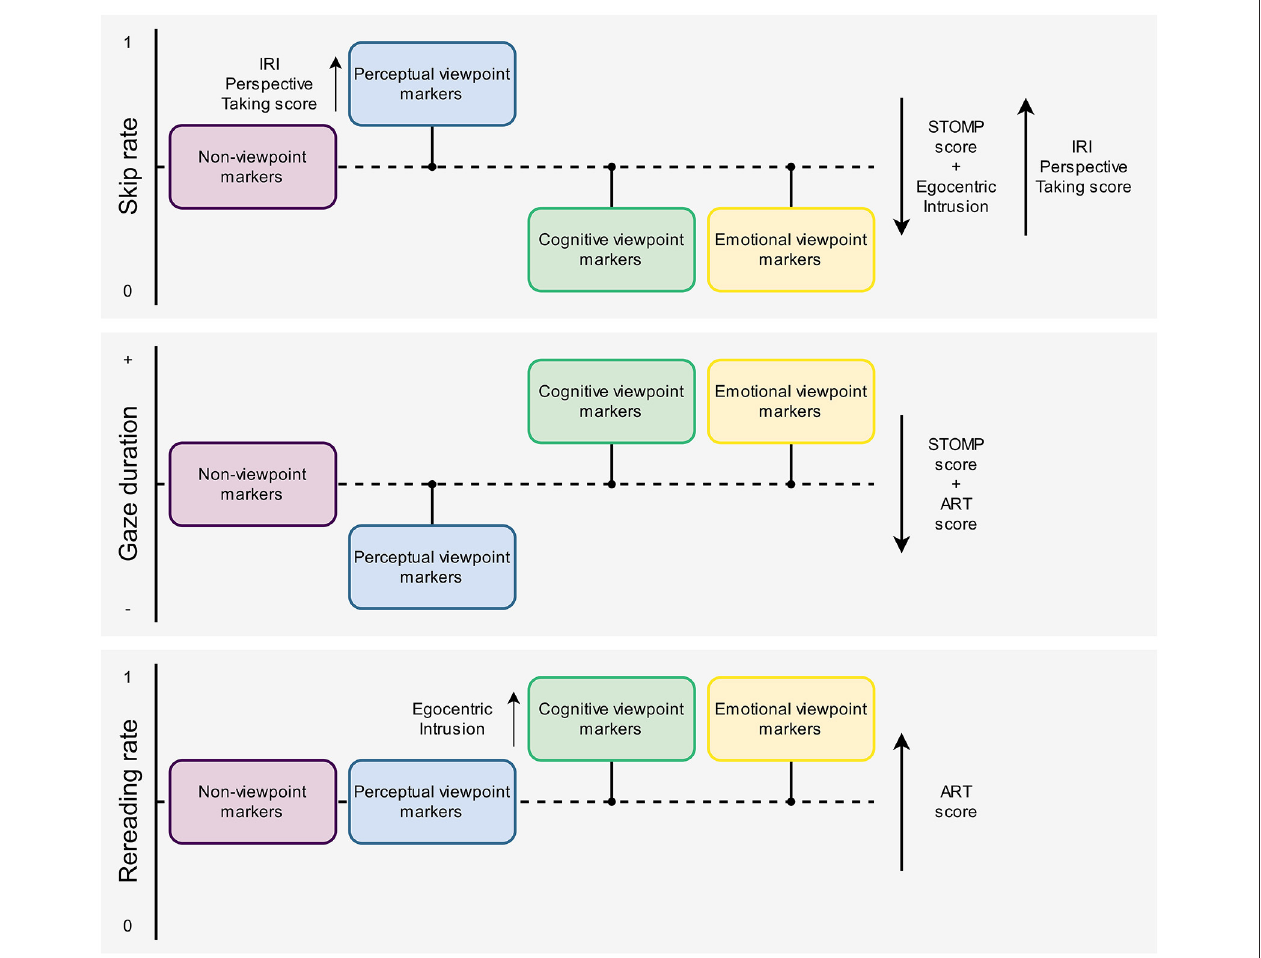
FIGURE 7 | Schematic summary of the results: compared to non-viewpoint markers, perceptual viewpoint markers were skipped more often, whereas cognitive and emotional viewpoint markers were skipped less often. Egocentric Intrusion and STOMP score decreased skip rate overall, and IRI Perspective Taking score increased skip rate overall, and for perceptual viewpoint markers specifically. Compared to non-viewpoint markers, perceptual viewpoint markers were fixated shorter, whereas cognitive and emotional viewpoint markers were fixated longer. STOMP score and ART score decreased gaze durations overall. Compared to non-viewpoint markers, perceptual viewpoint markers did not differ in terms of rereading rate, whereas cognitive and emotional viewpoint markers were reread more often. ART score increased rereading rate overall, and Egocentric Intrusion increased rereading rate for cognitive viewpoint markers